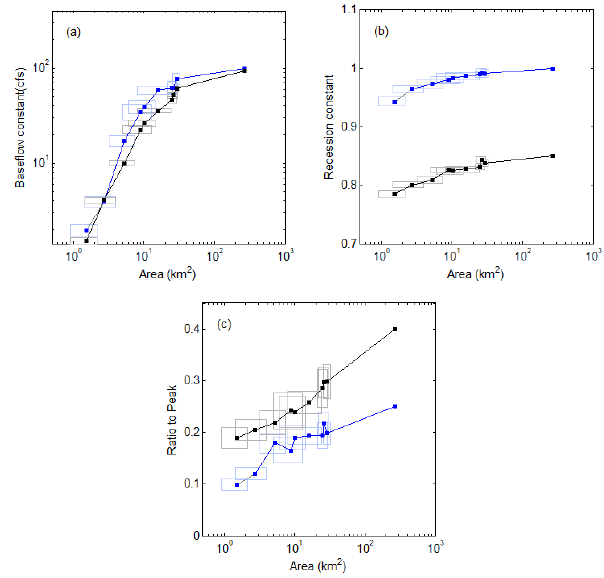
Fig. 8 Scaling property of HEC-HMS Calibrated parameters on hillslope II (baseflow) 4 Fig. 8. Scaling property of HEC-HMS calibrated parameters on hill- slope II